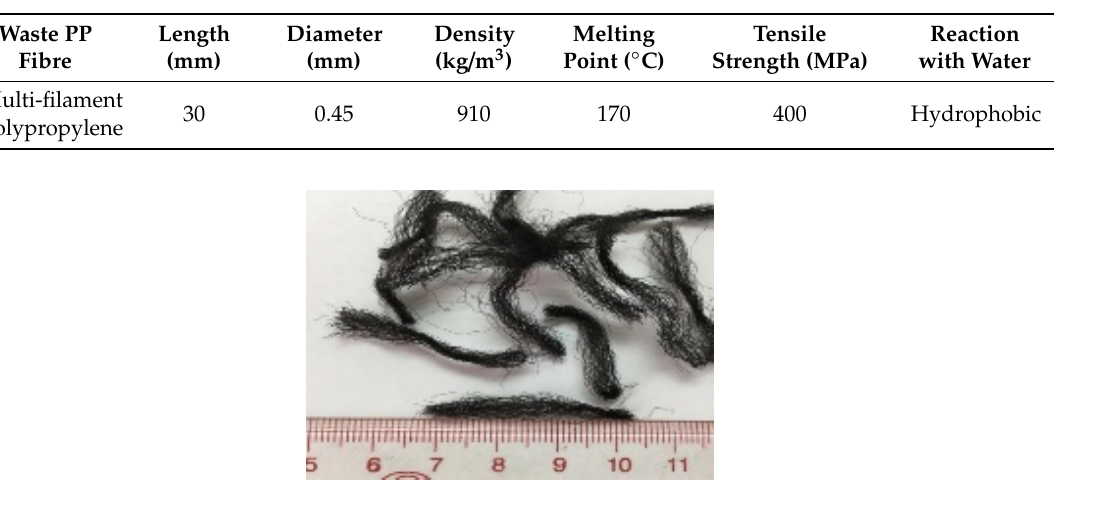
Figure 1. Waste PP fibres with 30 mm length.